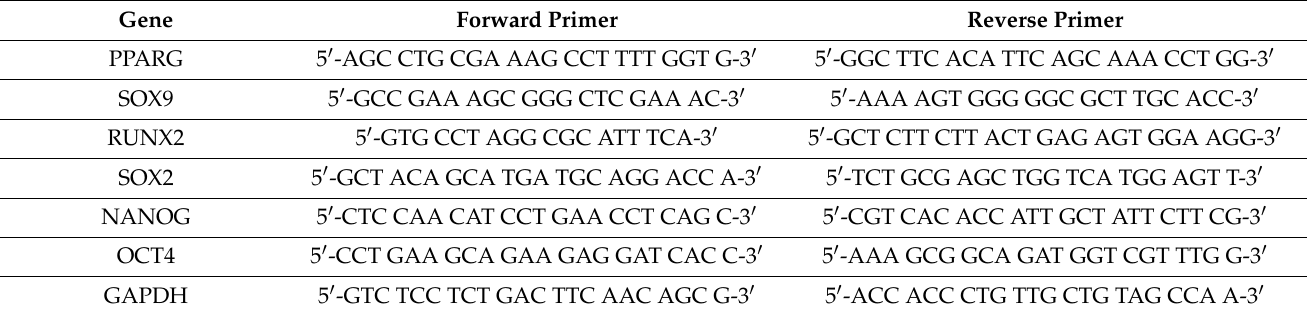
Table 1. List of